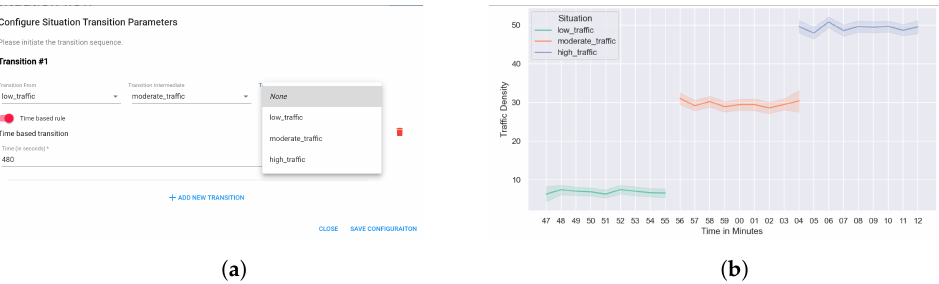
Figure 23. ( a ) Specifyingtime configuration. ( b ) Generated data based on configured